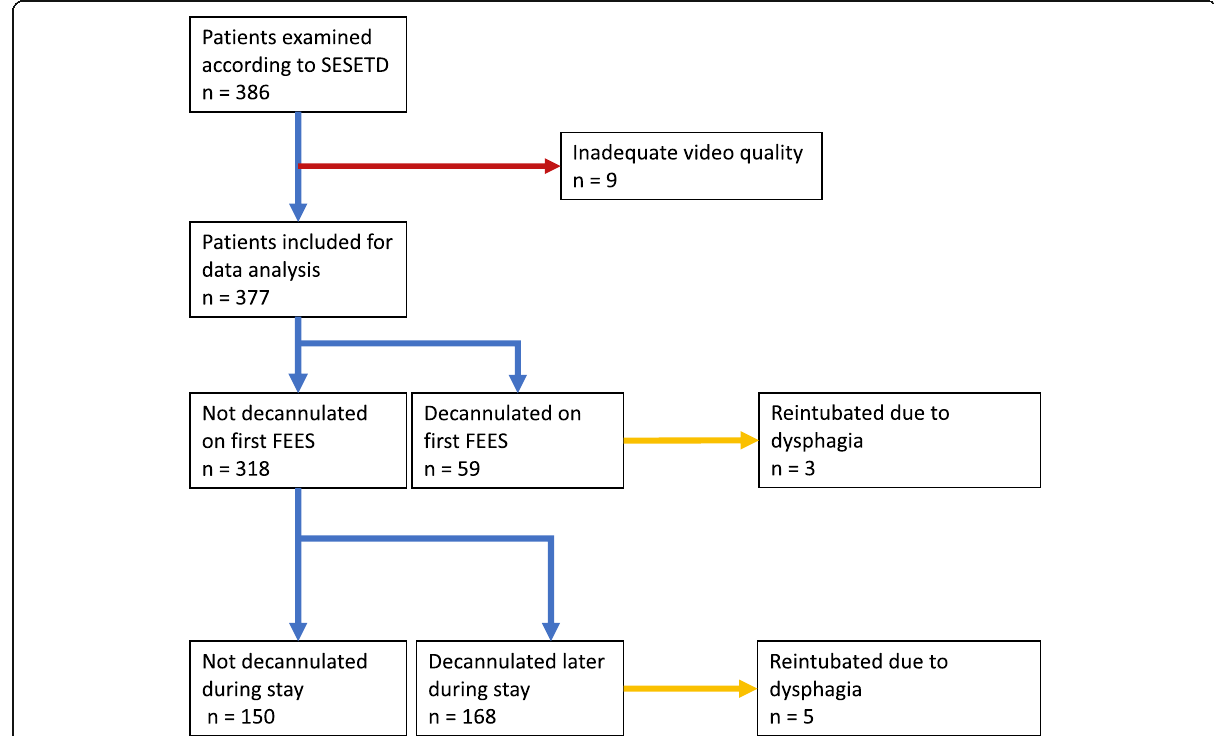
Fig. 2 Study profile; SESETD = Standardized Endoscopic Swallowing Evaluation for Tracheostomy Decannulation in Critically Ill Neurologic Patients; FEES = Flexible Endoscopic Evaluation of Swallowing; GCS = Glasgow Coma